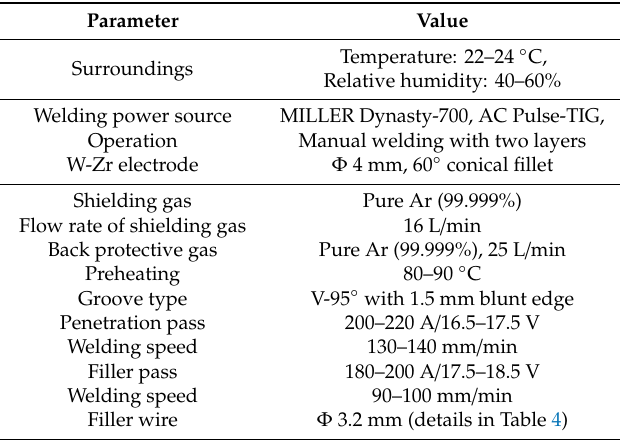
Table 3. Welding conditions and main process parameters.